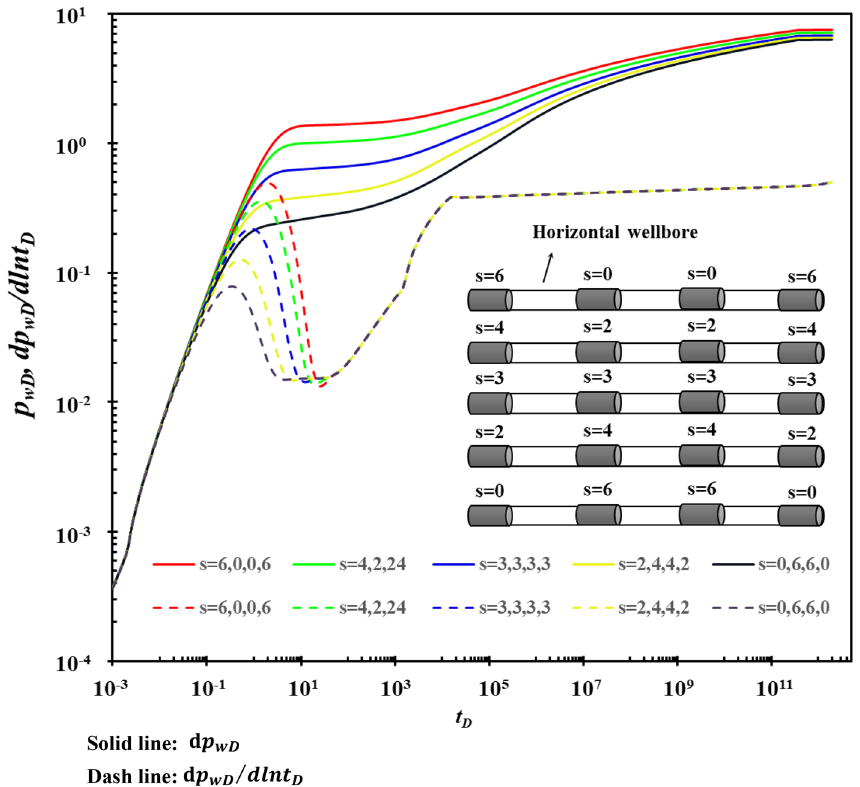
Figure 13. The effect of the size and distribution of the skin coefficient on type